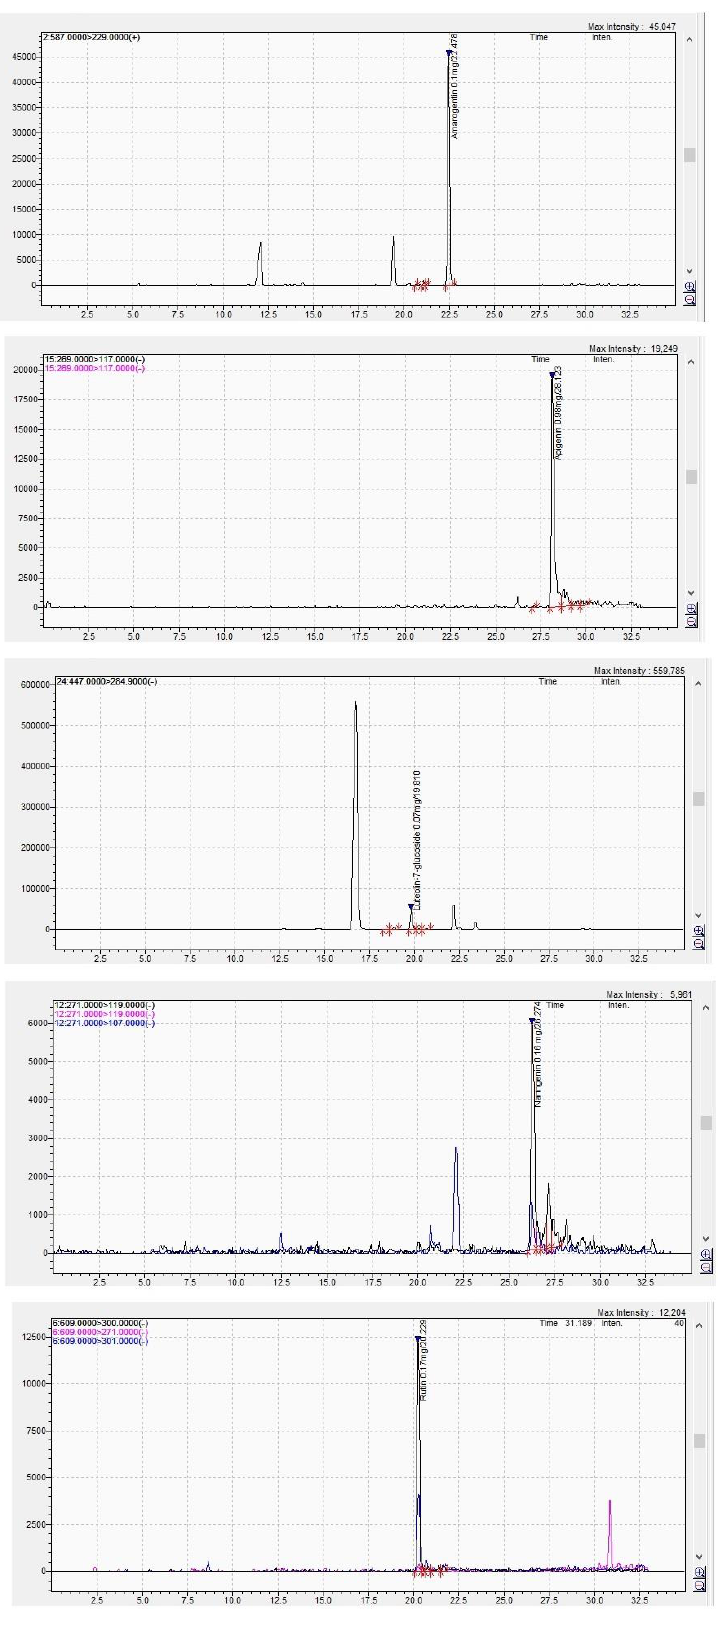
Figure 1. LC-MS chromatogram peaks of G. asclepiadea ethanolic extract—amarogentin, apigenin, luteolin-7- O -glucoside, naringenin, rutoside (top to bottom).